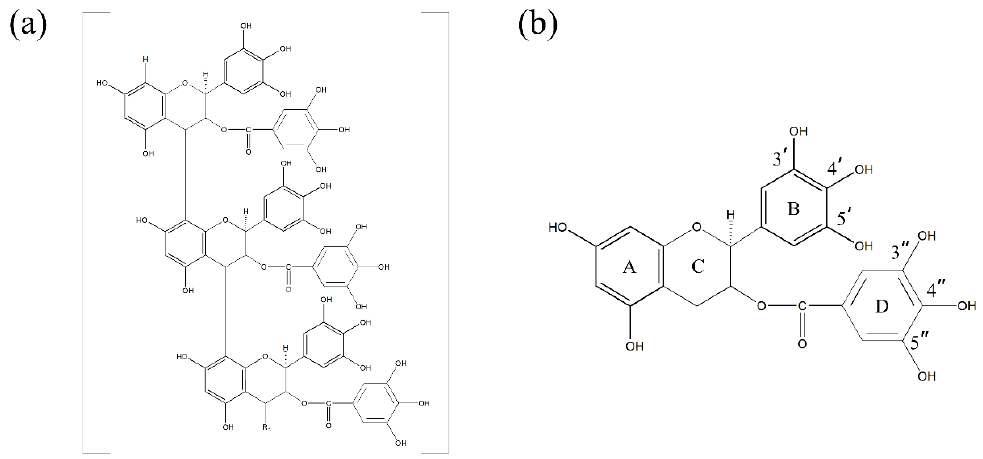
Figure 1. Chemical structures of ( a ) PT and ( b ) EGCG.